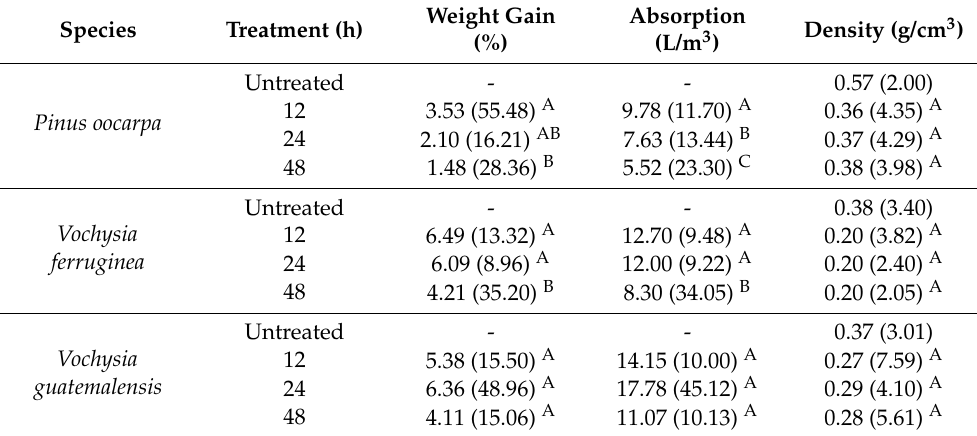
Table 1. Weight gain percentage, absorption and density of untreated wood and magnetic wood with three different immersion times in ammonia in three tropical wood species from fast-growth plantations in Costa